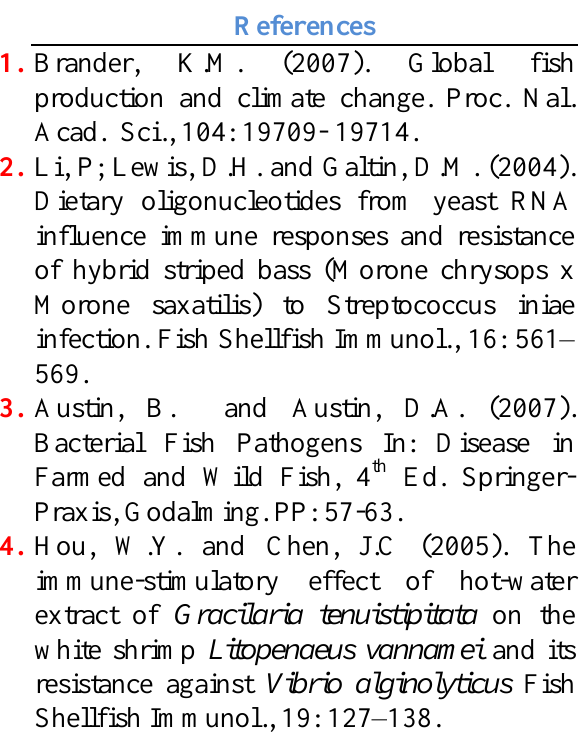
Table, 3: Effect of ginger and garlic in AST, ALT and ALP (Mean ±